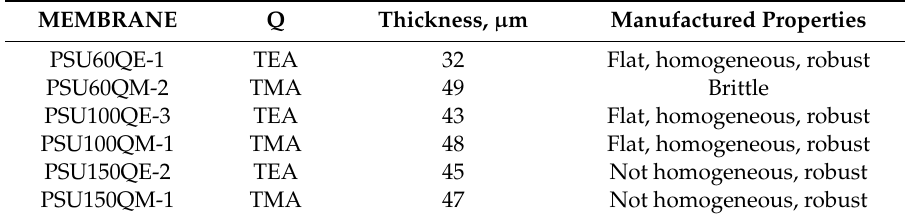
Table 2. Prepared